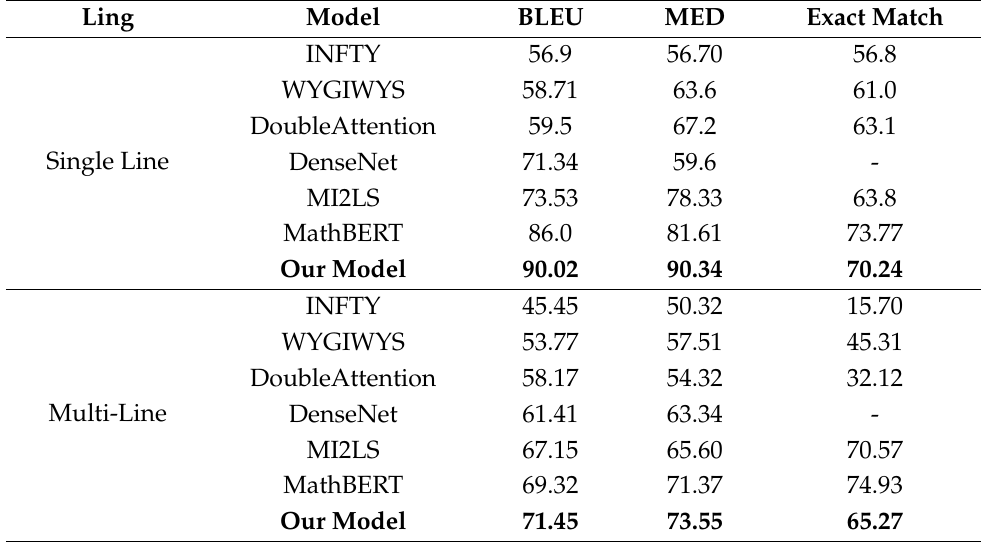
Table 2. Comparison between the proposed model and other similar models on img2latex 100k.